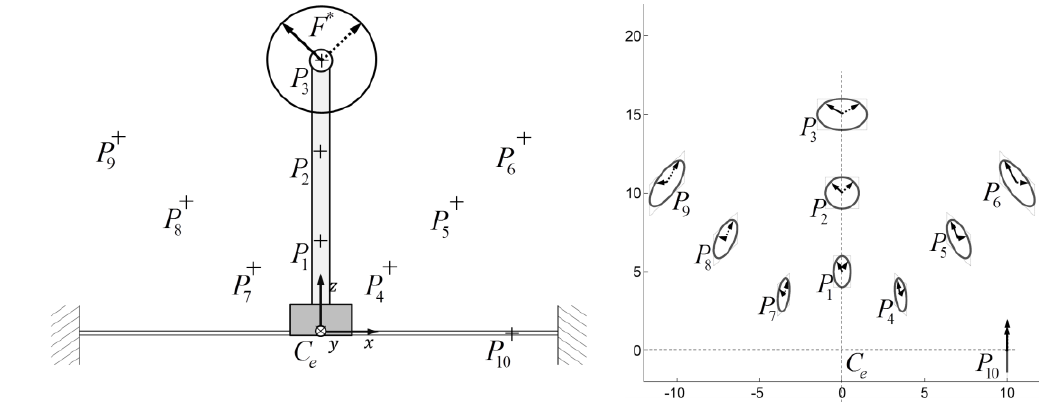
Figure 7. Scheme of the field of displacement (on the right) of points that move with the sensing-spring when the magnitude of applied force reaches the boundary of the nominal values ( ).